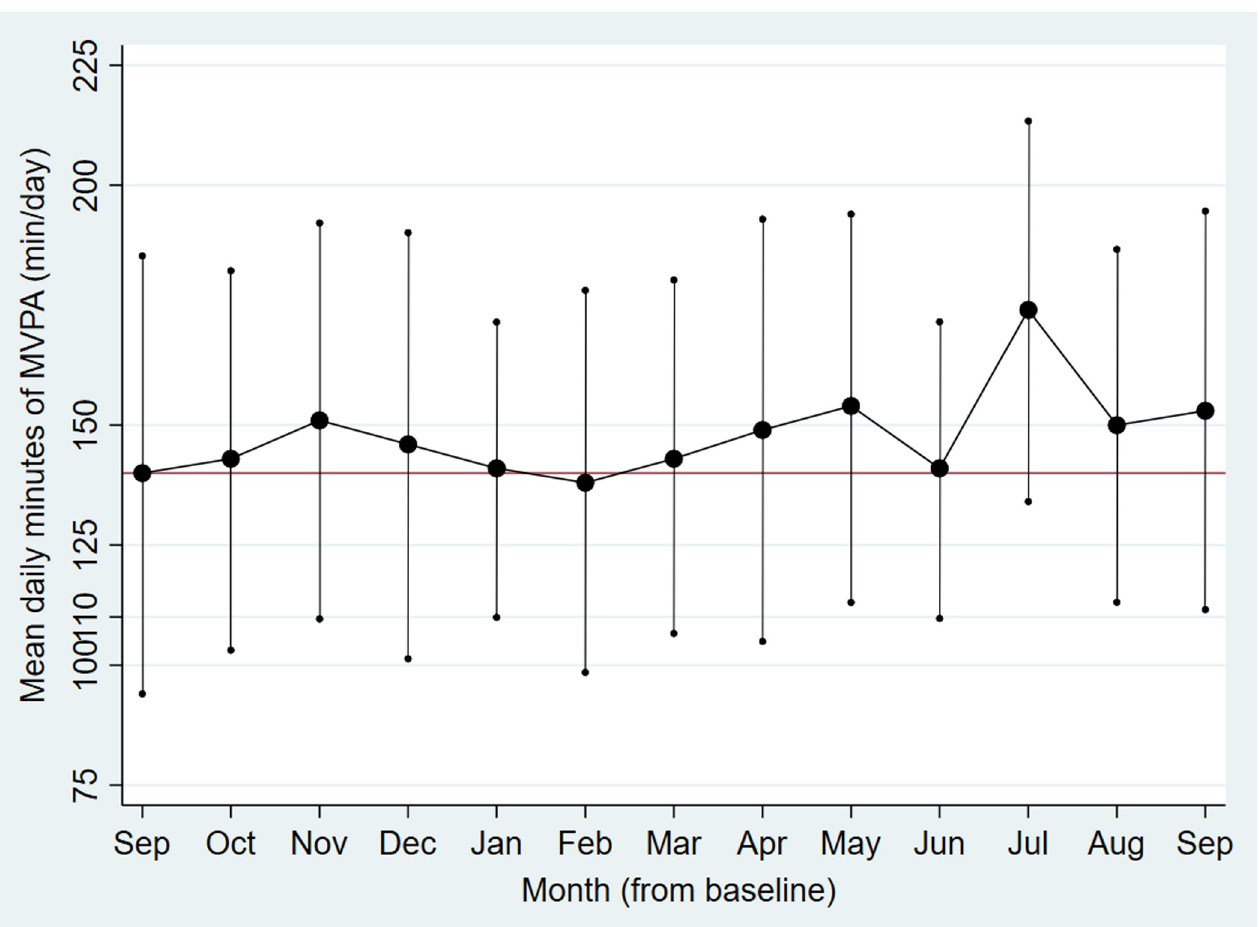
Fig 3. Monthly mean daily minutes in moderate-to-vigorous physical activity from baseline to end-of-follow-up. The RESTART pilot study 2017–18.